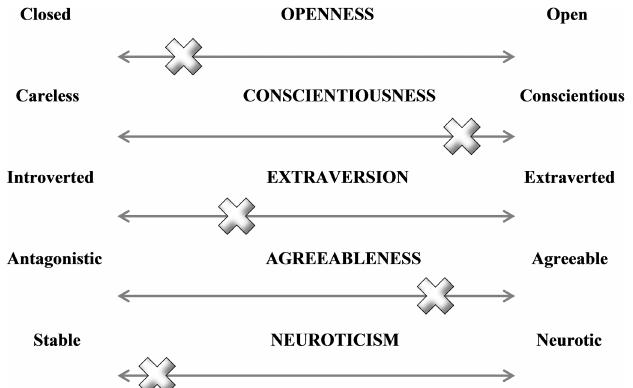
Fig 1. The FFM continuum and an example of how an individual’s personality might be scored (based on terminology from John & Srivastava,1999).